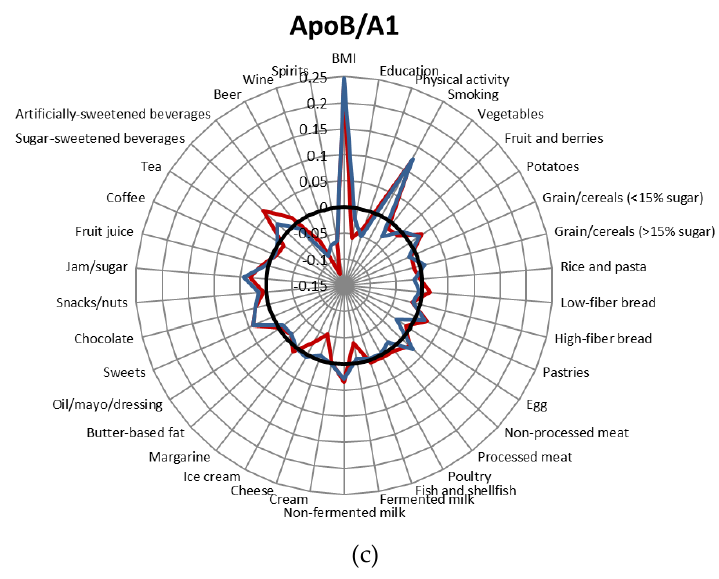
Figure 1. Correlations between lifestyle factors and food intake and ApoA1 concentrations ( a ), ApoB concentrations ( b ) and the ApoB/ApoA1 ratio ( c ). Blue: men; red: women; black: r = 0. Adjusted for age, screening date, total energy intake, BMI, leisure-time physical activity, alcohol and smoking habits. The analyses including beer, wine and spirits were not adjusted for